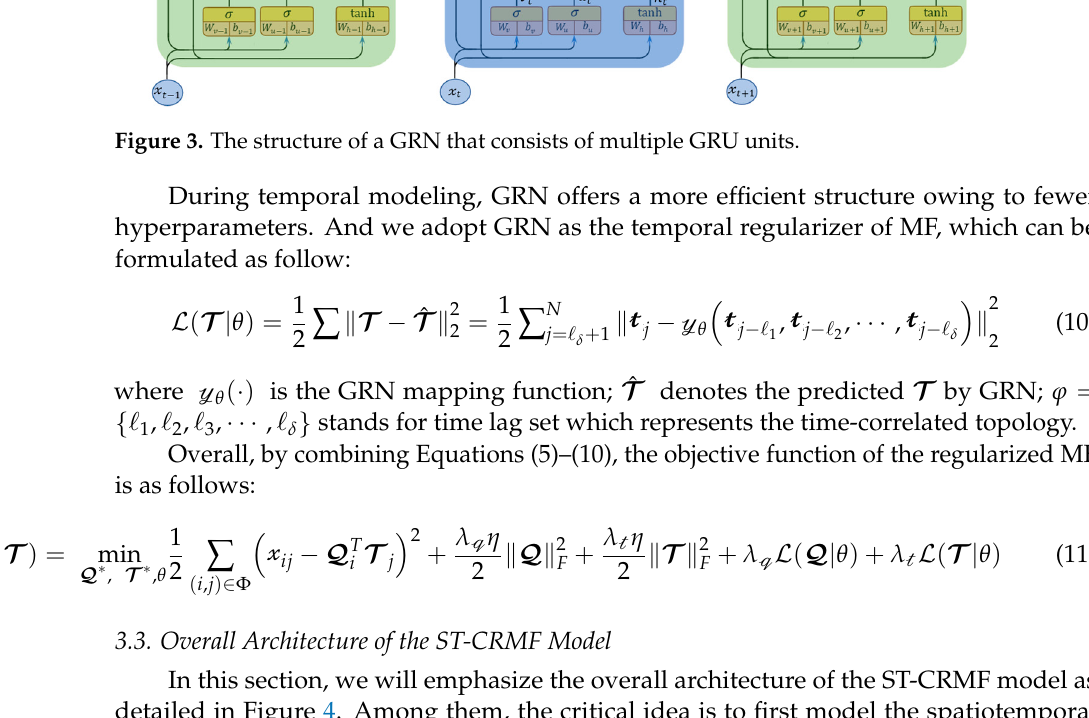
Figure 1. Illustration of multivariate time series forecasting (each 𝔁 (cid:3047) is a frame of traffic data at time step 𝑡 ).